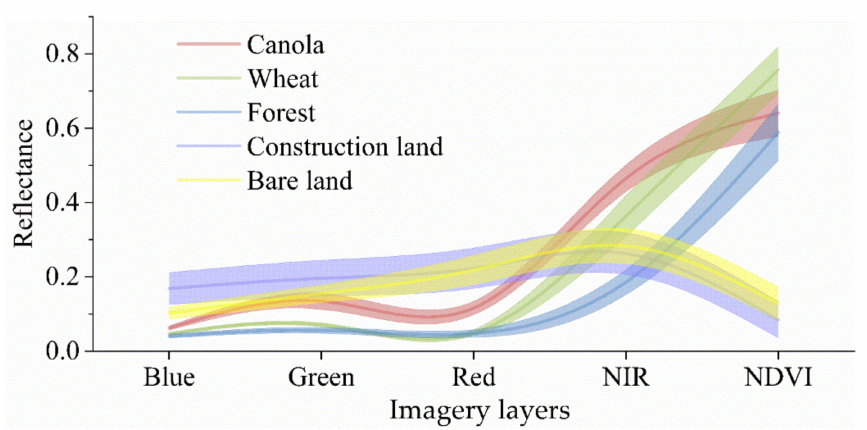
Figure 3. Spectral reflectance of various ground objects in Sentinel-2 imagery dated 20 March 2020 in the first study area. That imaging date was the canola flowering